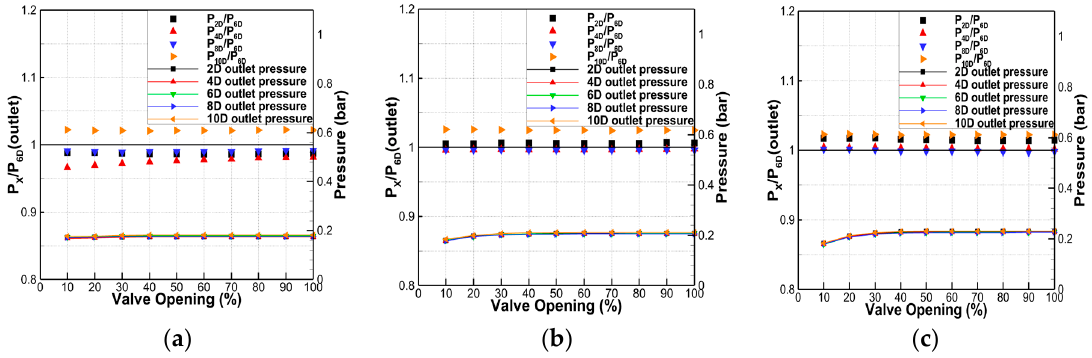
Figure 7. Comparison of pressure in the valve downstream: ( a ) 1000 RPM; ( b ) 1500 RPM; ( c ) 2000 RPM.